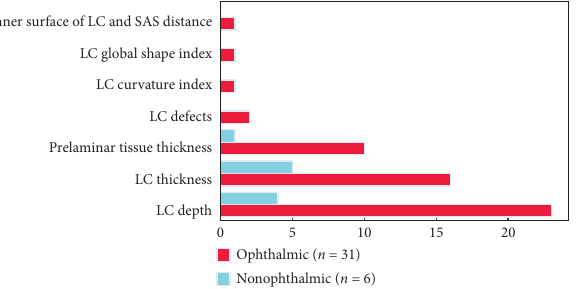
Figure 3: Number of occurrences of each lamina cribrosa struc- tural feature published in the literature. The value n corresponds to the total number of studies for each